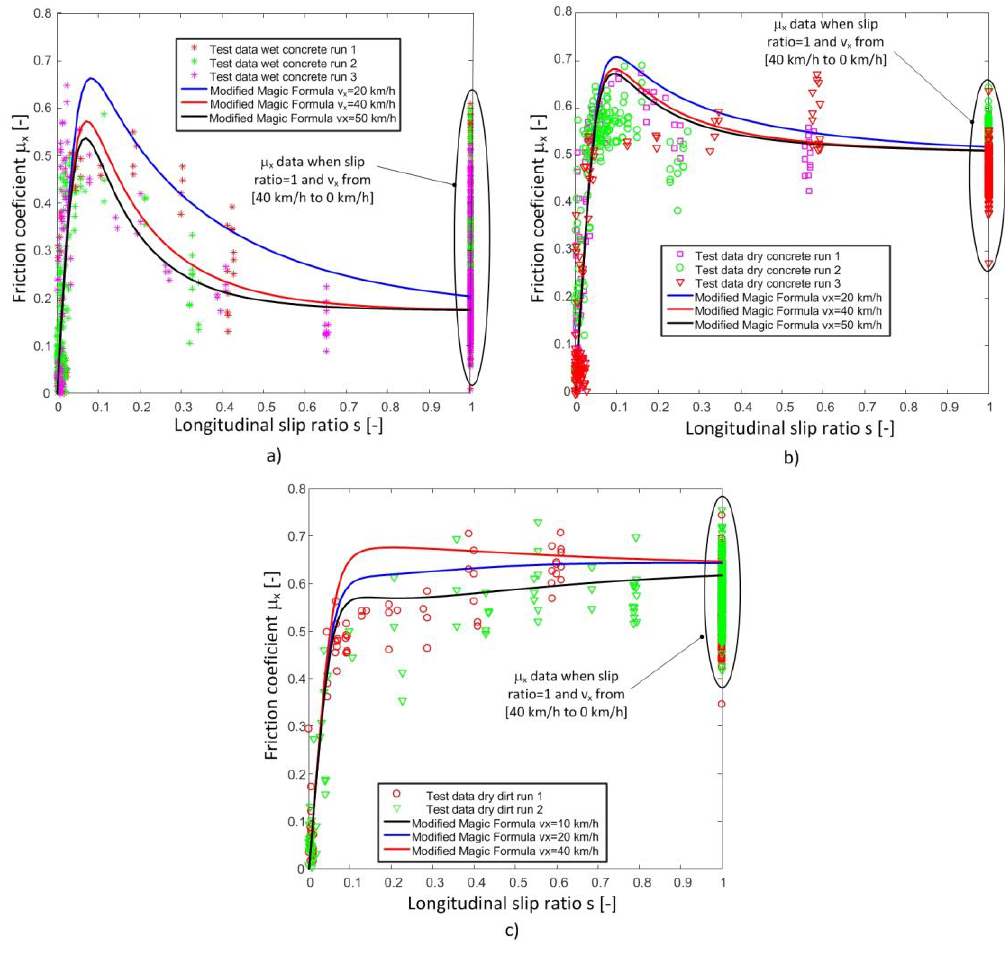
Figure 8. Friction coefficient versus slip at different speeds. (a) Wet concrete road. (b) Dry concrete road. (c) Dry dirt road.